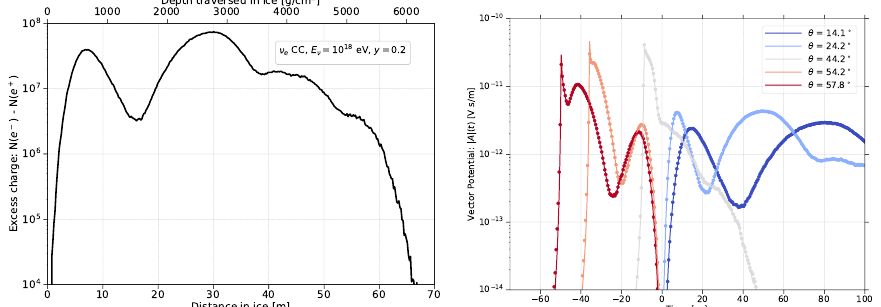
Figure 6. Left panel: Longitudinal profile of the excess charge Q ( z (cid:48) ) of a shower in homogeneous ice, initiated by an electron neutrino of energy 10 18 eV in a charged-current (CC) interaction. The fraction of energy carried by the produced electron is ( 1 − y ) = 0.8, and that carried by the fragments of the interaction with a nucleon of the medium is y (cid:39) 0.2. Right panel: The vector potential for observers at different positions. The dots are directly obtained in full ZHAireS simulations in ice, while the solid lines are the result of the semi-analytical approach [127]. It uses as input the longitudinal distribution of the excess charge in the left panel and the parameterization of the form factor in Equation (25) for a weighted mixture of a 0.8 × 10 18 eV electromagnetic shower and a 0.2 × 10 18 eV hadronic shower. Each curve corresponds to an observer located 100 m away from the starting point of the shower at a different polar angle θ relative to the start point ( z (cid:48) = 0). Observers close to the Cherenkov angle θ C = 55.8 ◦ see the start of the shower highly compressed in time, while those at lower angles see the time compression for later shower